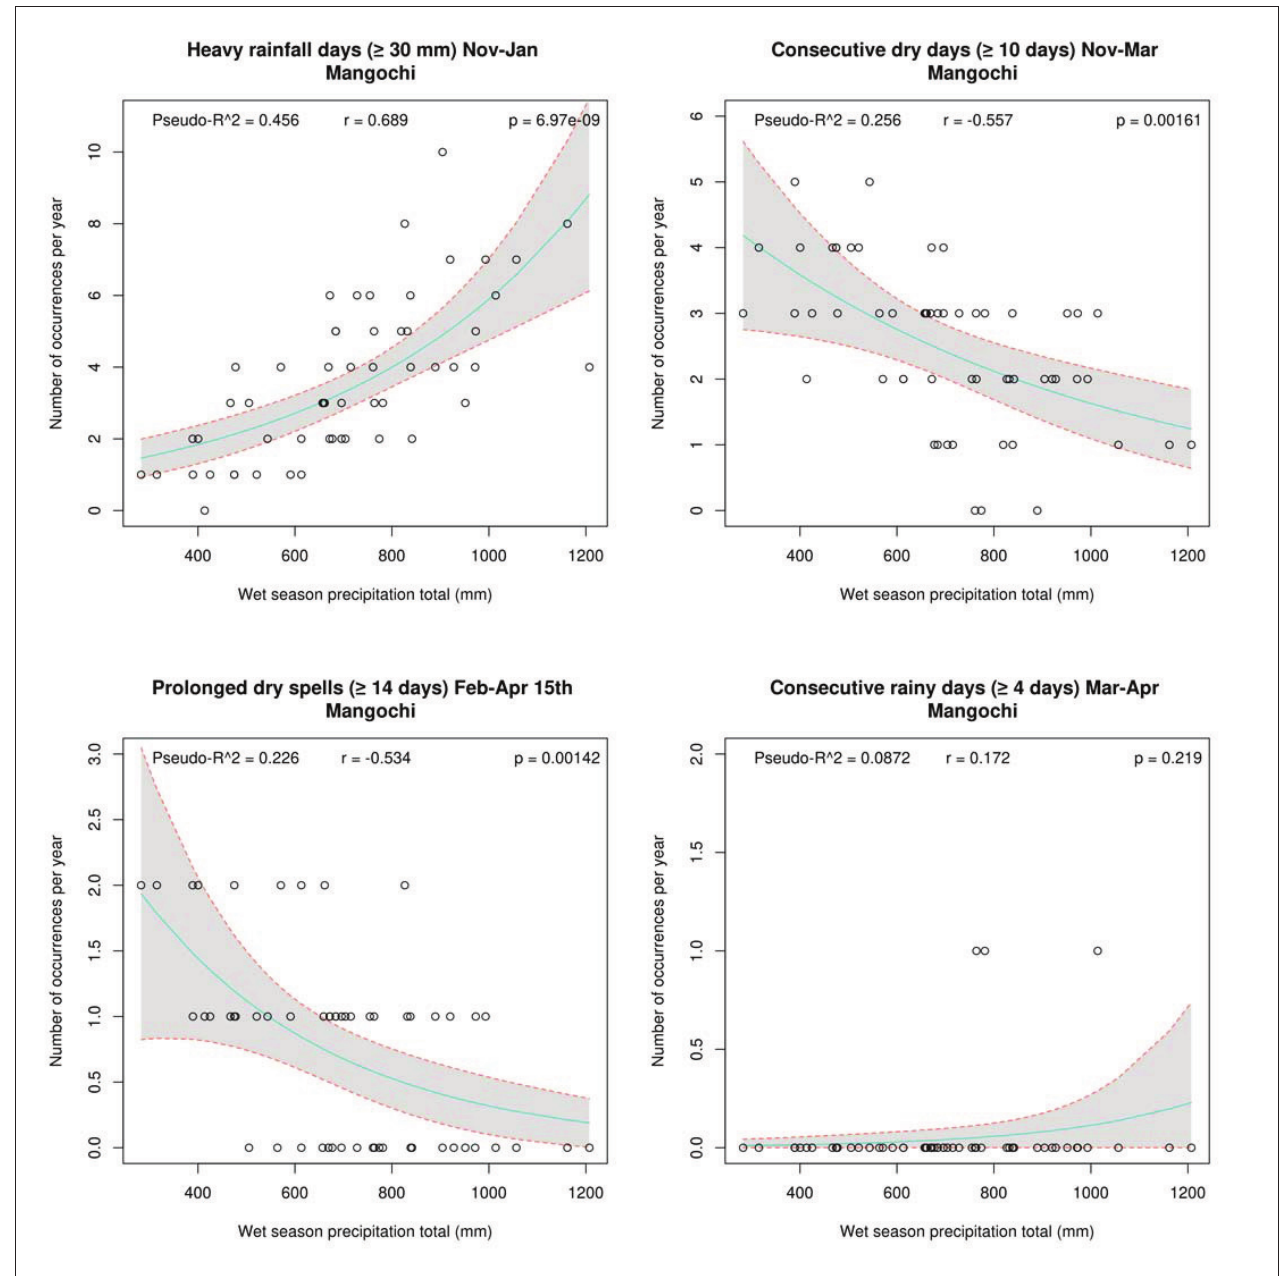
FIGURE 3 | Results of correlation analysis between the agro-climatic indices developed through the iterative process and wet season precipitation totals for Mangochi station, Mangochi district. Clockwise from top left: “heavy rainfall” events November–January, “dry spell 1–2 weeks” November–March, “consecutive 4-day rainfall” March–April, and “prolonged dry spells” February–April